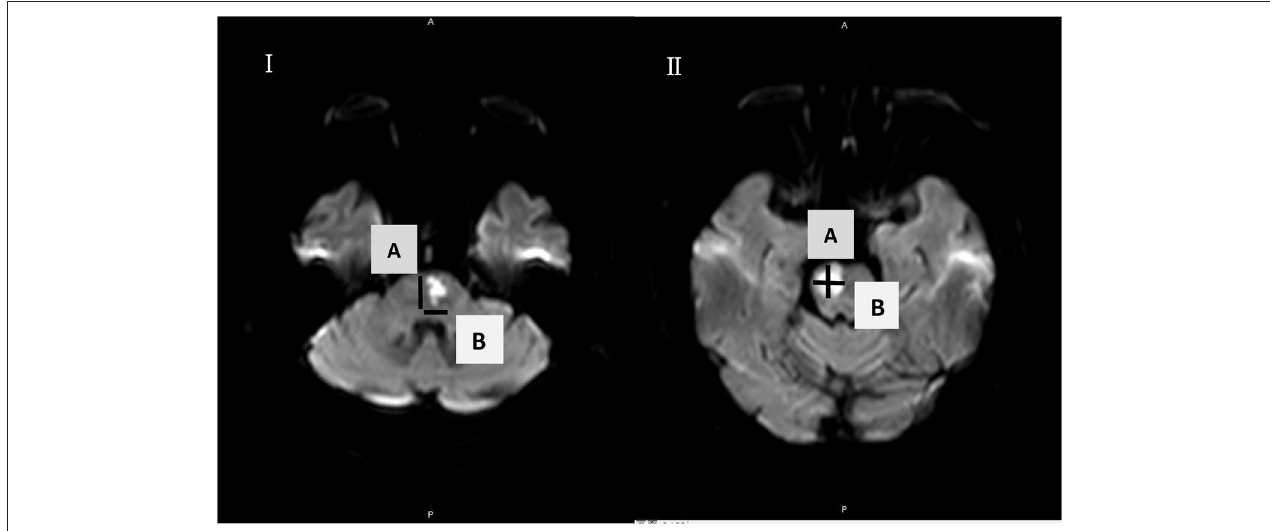
FIGURE 2 | Acute pontine infarctions on axial diffusion-weighted imaging are shown in I and II. The maximal ventrodorsal (A) length and (B) width of each infarct were measured on axial MRI. A × B was used to define the infarction size